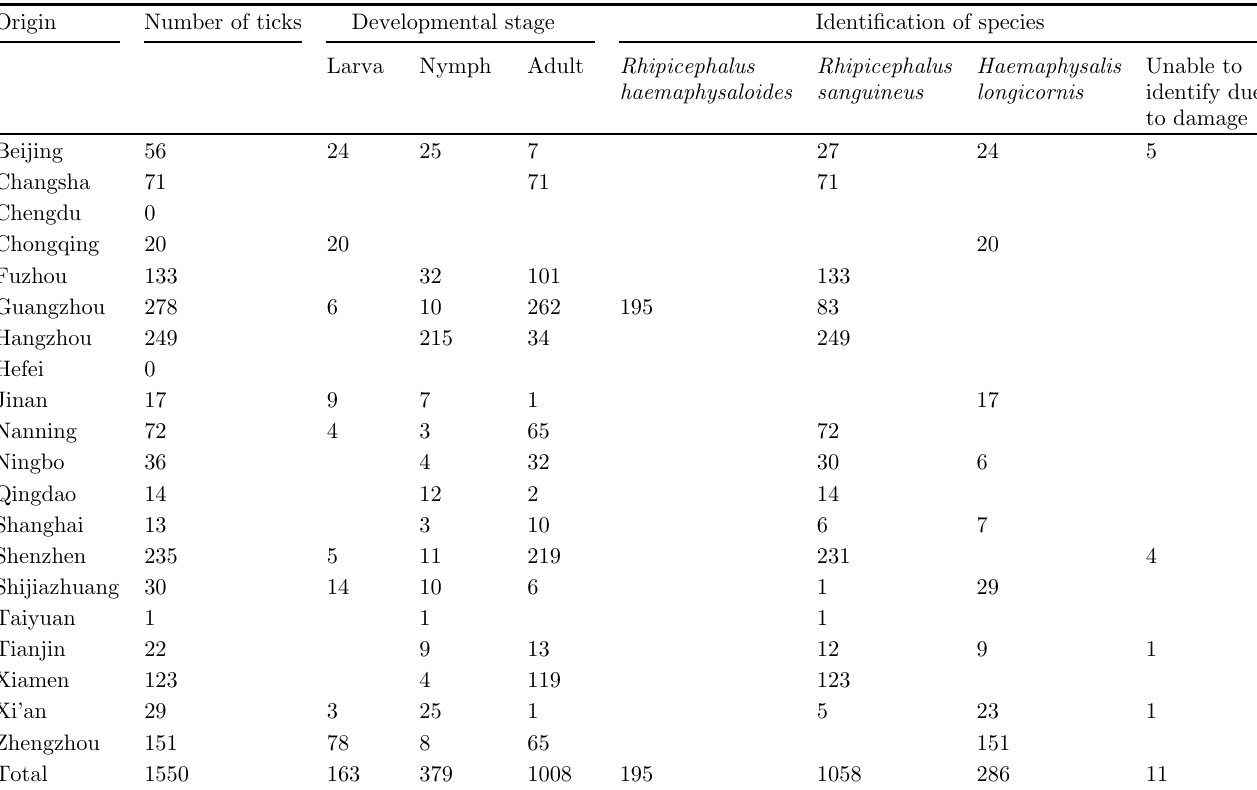
Table 3. Identi fi cation of tick samples collected from dogs.